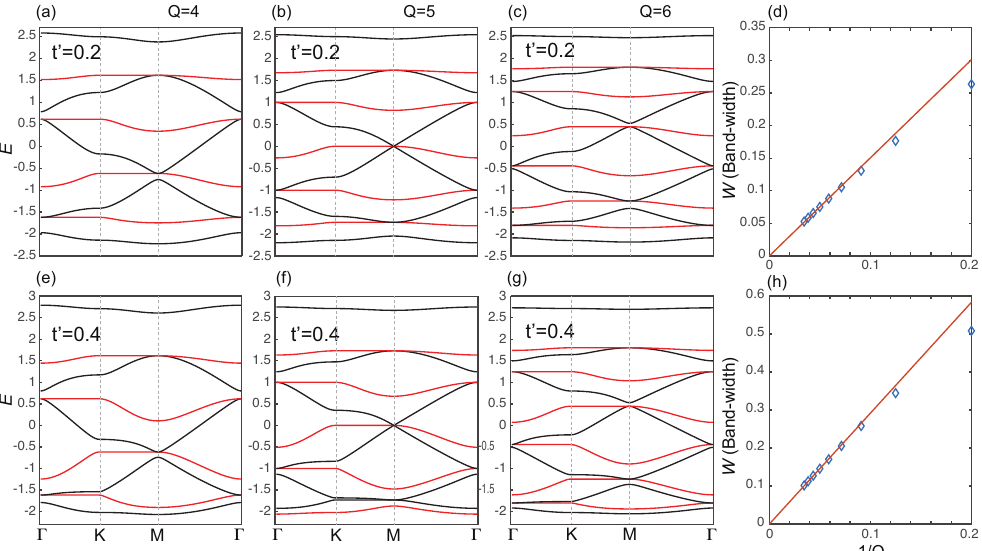
Figure 4. Band structures of the square network superstructures with the next nearest-neighbor hopping processes ( t (cid:48) ) between four sites around the dot-type link in Figure 1a. The flat bands in Figure 1b–d deform to the nearly flat bands colored red in ( a – c ) and ( e – g ) for t (cid:48) = 0.2 and 0.4, respectively. In ( d , h ), we plot the bandwidth of the nearly flat band as a function of 1/ Q . Here, we take the maximum bandwidth among all the nearly flat bands for a given Q